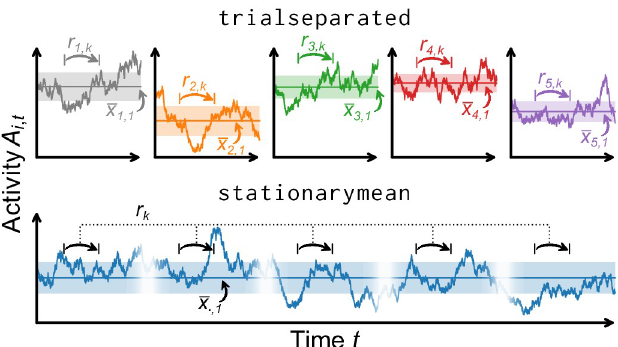
Fig 4. Illustration of the two methods for determining the correlation coefficients r k from spiking activity A t . Both methods assume a trial structure of the data (discontinuous time series) Top : The trialseparated method calculates one set of correlation coefficients r i , k for every trial i (via linear regression). Bottom : The stationarymean method combines the information of all trials to perform the linear regression on a single, but larger pool of data. This gives an estimate of r k that is bias corrected for short trial